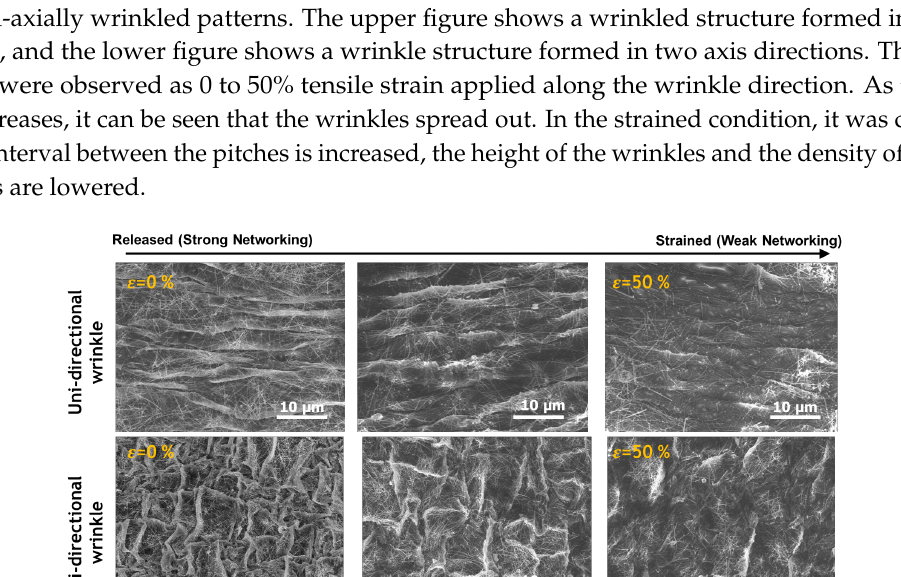
Figure 4. Resistance changes of wrinkled hybrid electrodes according to mechanical tensile strains.